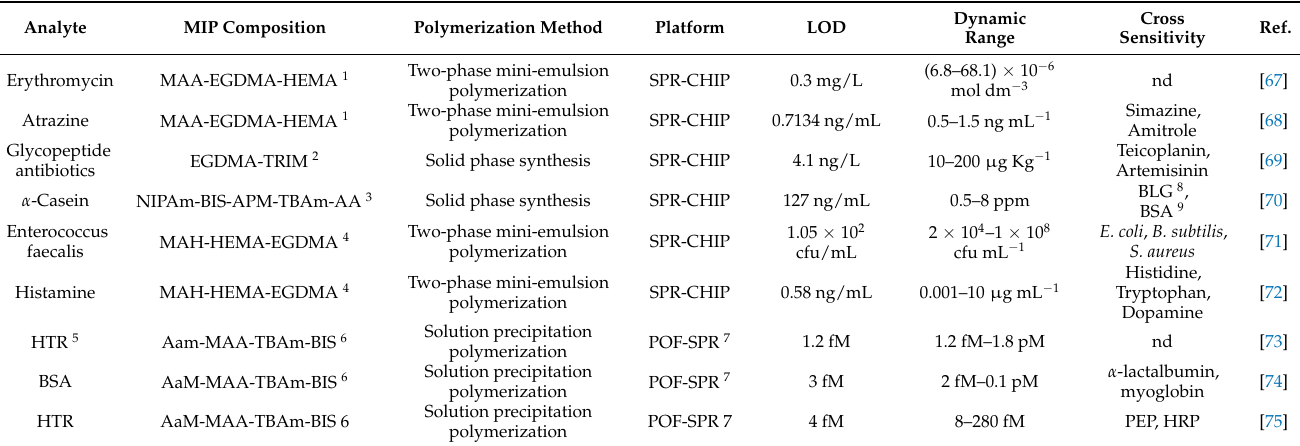
Table 2. Summary of the nanoMIP-based SPR sensors described in Section